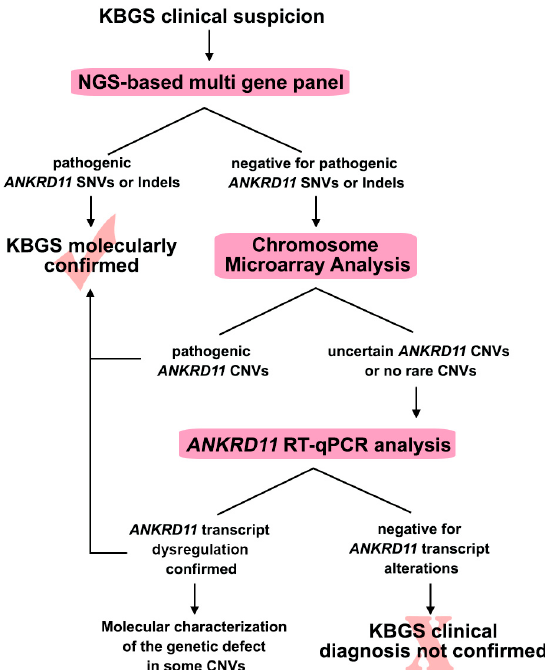
Figure 1. The KBGS flowchart. The figure summarizes the molecular diagnostic work-up that was used in the present study and which led to the molecular diagnosis in our KBGS patients. SNV: Single Nucleotide Variation; CNV: Copy Number Variations.